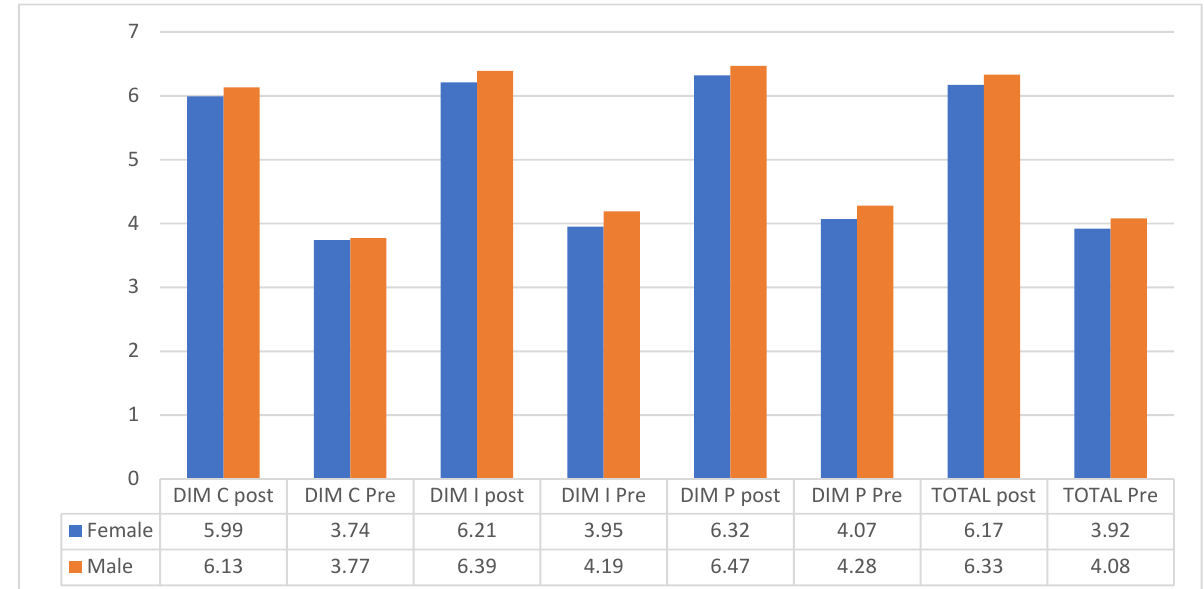
Figure 3. Pre ‐ test and post ‐ test descriptive statistics according to the gender and design variables. Figure 3. Pre-test and post-test descriptive statistics according to the gender and design variables. Source: own elaboration. Source: own elaboration.